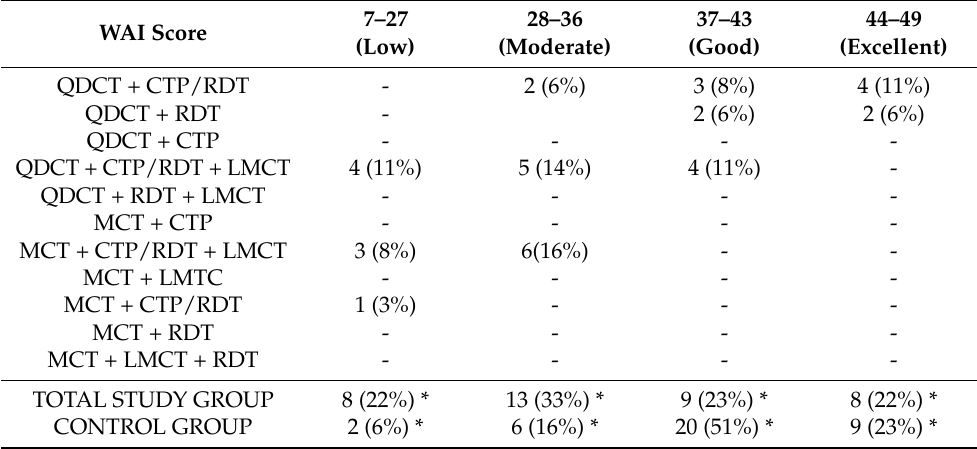
Table 4. Results of the WAI questionnaire in relation to the treatment adopted on cases with BrC. WAI